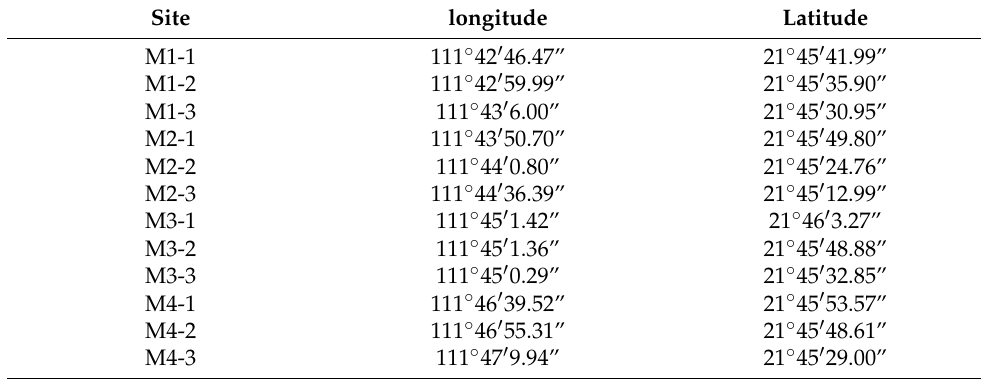
Figure A1. Schematic diagram of mangrove survey section. Table A1. Latitude and longitude coordinates of the mangrove survey quadrats.